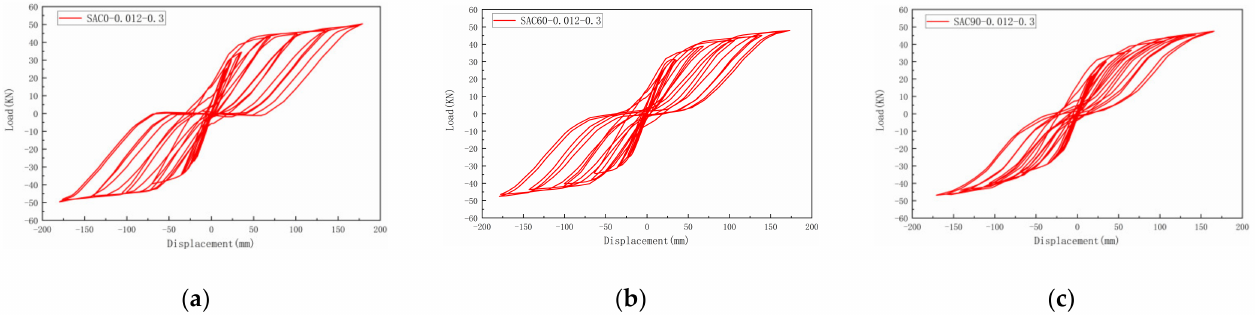
Figure 8. Hysteretic curves of SAC joints after exposure to different temperatures. ( a ) Specimen SAC0-0.012-0.3, ( b ) Specimen SAC60-0.012-0.3, ( c ) Specimen SAC90-0.012-0.3.